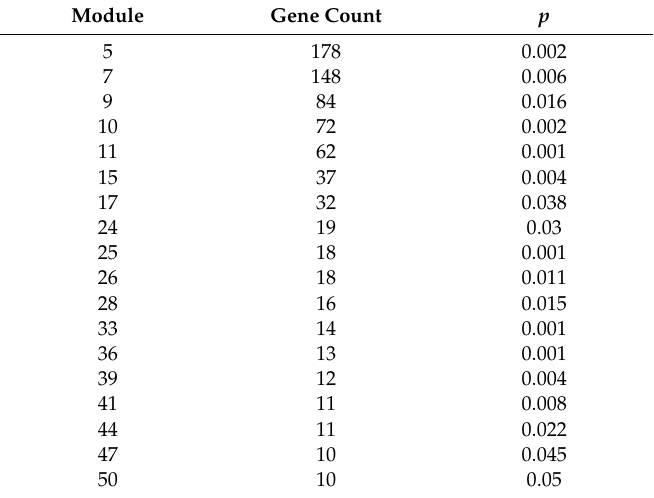
Table 4. Differential co-expression analysis of modules that were significantly different in PAX3 vs PAX7 fusion positive patients. For brevity, only modules with significant ( p < 0.05) differences are reported (see Table S4 for full results).